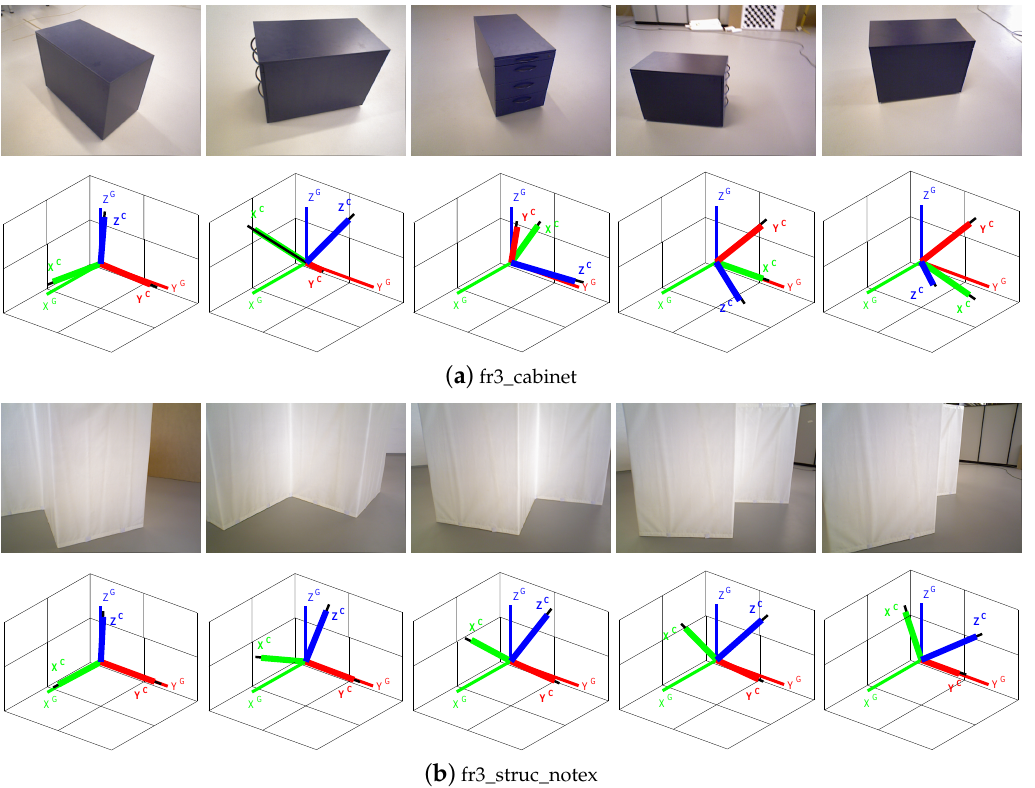
Figure 8. Results of camera orientation estimated by our proposed method on the TUM RGB-D dataset: ( a ) ‘fr3_cabinet’ sequence. ( b ) ‘fr3_struc_notex’ sequence. Estimated orientation of each frame is shown in the bottom of the RGB image. Colored thick and thin lines respectively denote current orientation and global MW axes (determined in the first frame); black lines represent ground orientation.